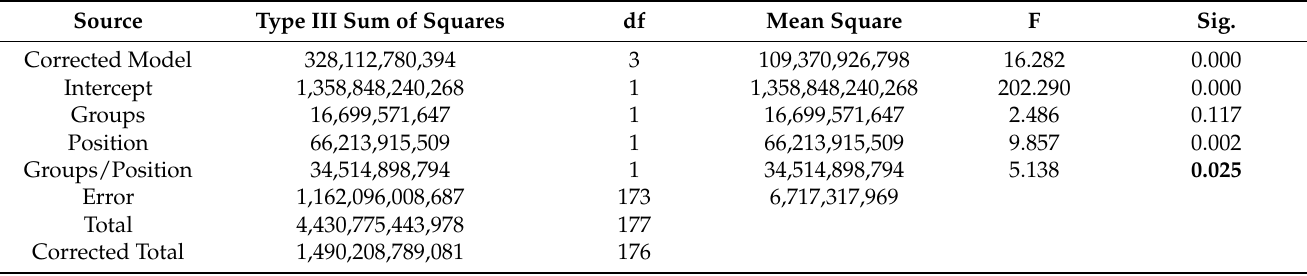
Table 3. Two-way ANOVA results of testing the significance of position and method on